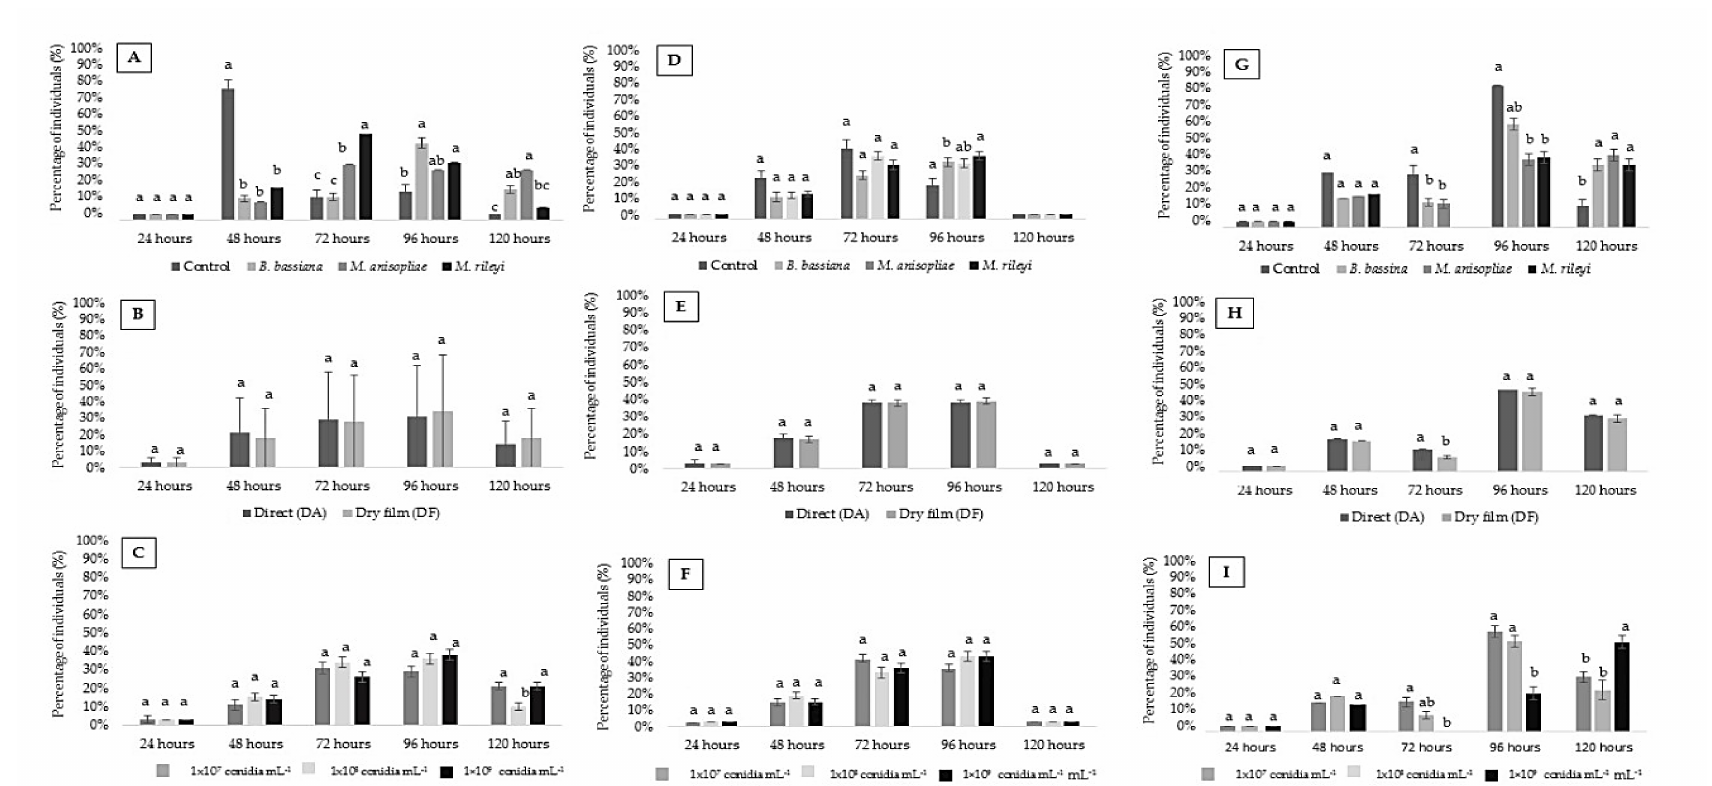
Figure 2. Percentage of Chrysoperla externa first, second and third instar (larval) period (% ± standard error) that changed their instar in each larval period after application of entomopathogenic fungi Beauveria bassiana , Metarhizium anisopliae and Metarhizium rileyi (T: 25 ± 1 ◦ C, RH 70 ± 10% and 12 h photoperiod (light / dark)). ( A – C ) Individuals who changed from first to second urge, factor = P (products), A (application methods) and C (concentrations), respectively. ( D – F ) Individuals who changed from second to third instar, factor = P (products), A (application methods) and C (concentrations), respectively. ( G – I ) Individuals who changed from third instar to the pre-pupa, factor = P (products), A (application methods) and C (concentrations), respectively. Values (%) followed by equal letters at each assessment time do not di ff er from each according to a Tukey test at 5%